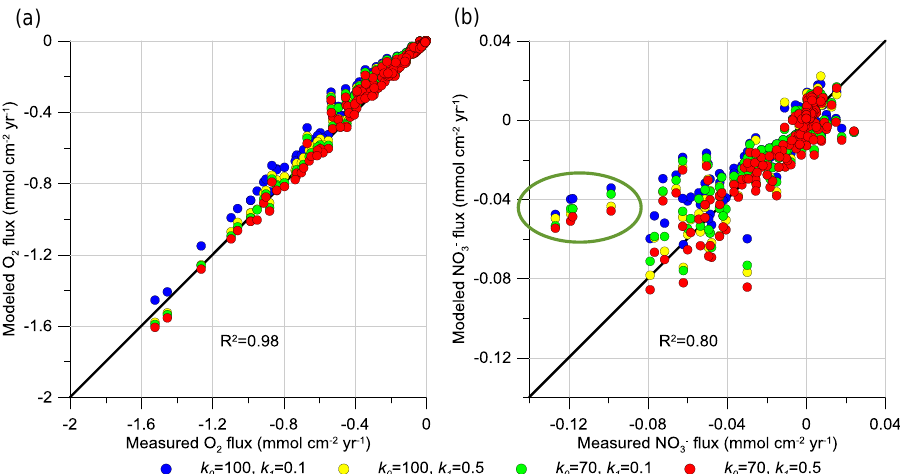
Figure 3. Modeled versus measured benthic fluxes of (a) O 2 and (b) NO − symbols show the sensitivity of the fluxes for different combinations of rate constants k 0 and k 1 ; the red symbols denote the baseline fit used in Figs. 4 to 6. The symbols marked with a green ellipse indicate the stations on the Peruvian margin characterized by enhanced NO − by sulfur oxidizing bacteria (Dale et al., 2016). The R 2 values for baseline fit are provided on each plot ( p (cid:28)